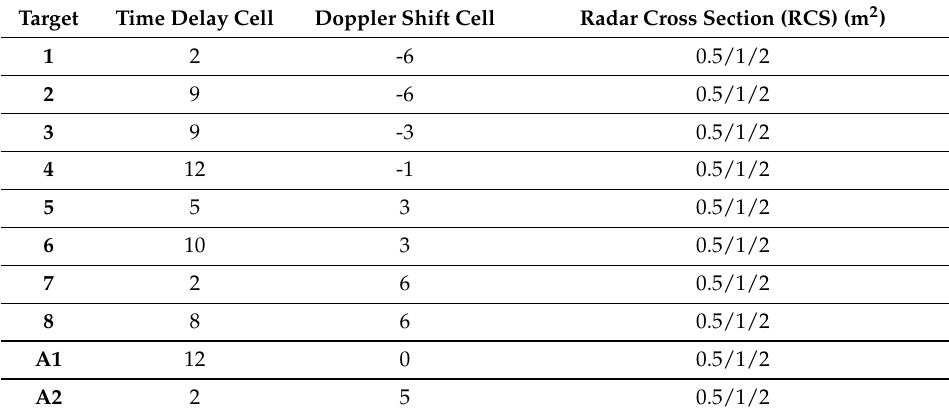
Table 1. Time delay and Doppler shift information of the targets in the